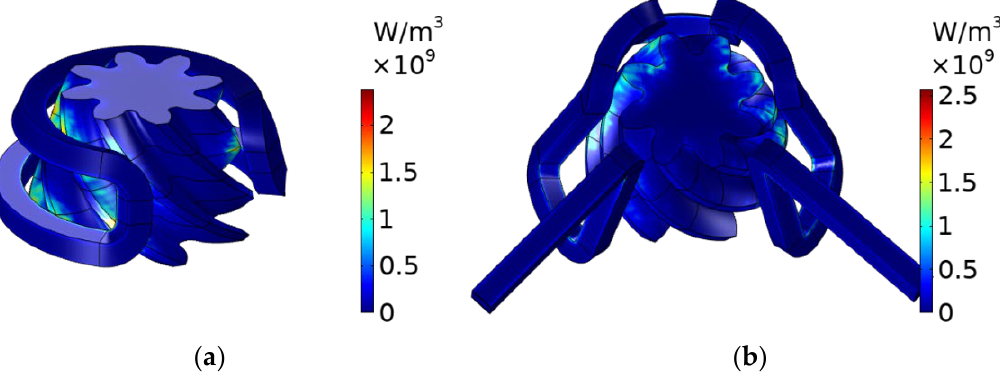
Figure 13. Cloud diagram of electromagnetic heat distribution during heating of two coil structures: ( a ) TC heating, ( b ) LC heating.